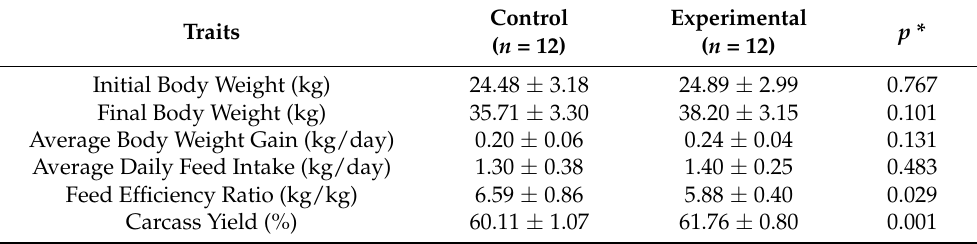
Table 2. Performance characteristics of control and experimental SOD-rich melon group of Tuj lambs. Traits